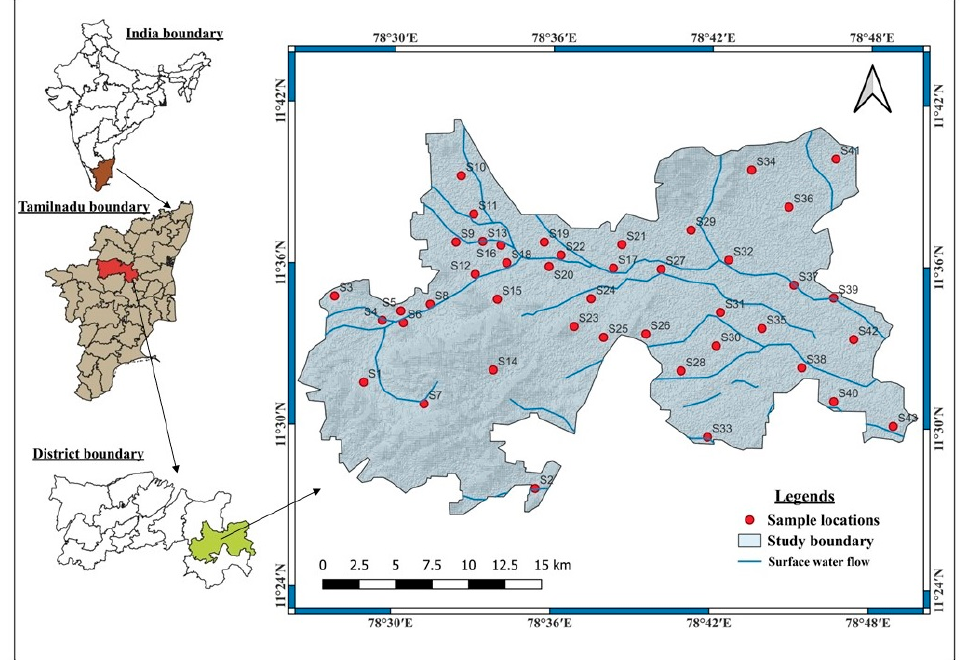
Figure 1. Groundwater sample locations in study region.